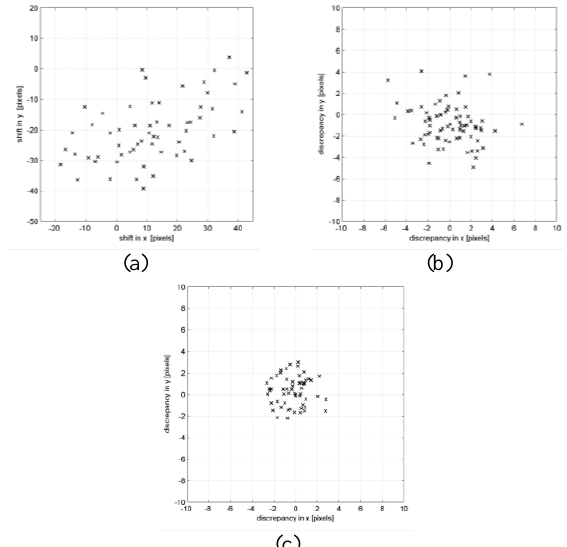
Figure 3. Discrepancies between the manually measured and transformed coordinates of the markers using only a shift (a), using parameters from stereo calibration (b) and using parameters from space resection